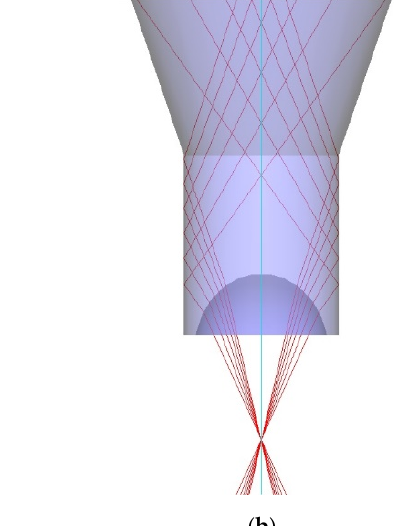
Figure 3. ( a ) Ray tracing simulation for a flat outlet concentrator. ( b ) Ray tracing simulation for a concave outlet concentrator.